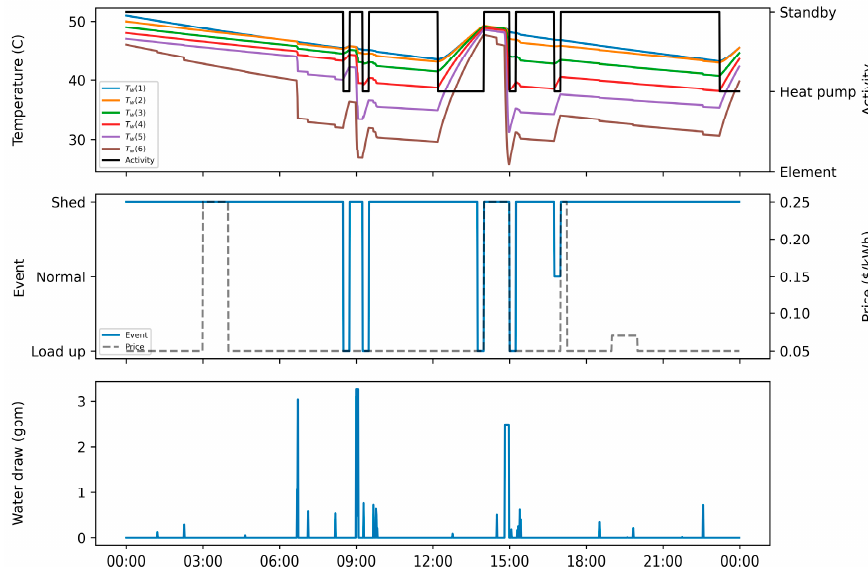
Figure 9. Operation based on RL agent #4.